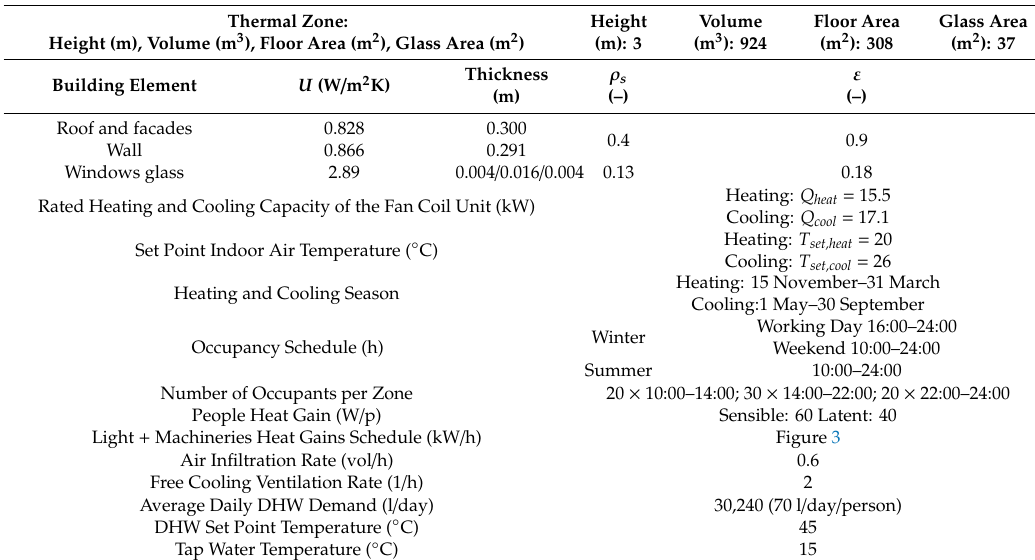
Table 4. Building simulation